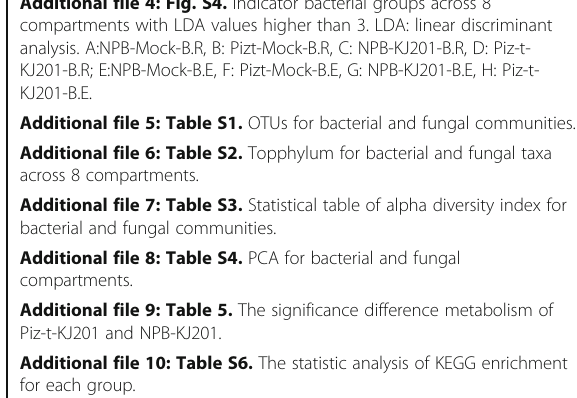
Additional file 10: Table S6. The statistic analysis of KEGG enrichment for each